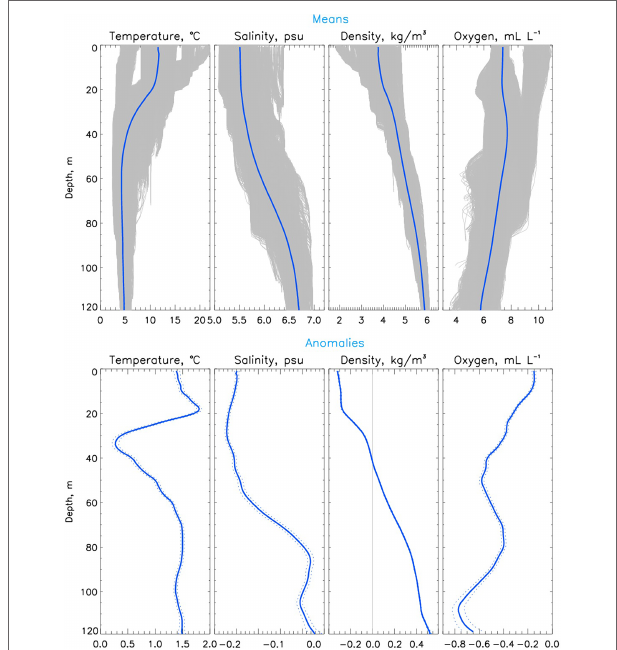
FIGURE 8 | (Top) mean and (bottom) anomalous vertical profiles of spatially and temporally averaged water temperature, salinity, density, and dissolved oxygen based on 2016-2021 glider observations in the Bothnian Sea. In the upper row, grey lines show individual profiles whereas blue lines show their averages. Temperature, salinity and dissolved oxygen anomalies are computed relative to their monthly climatologies; dotted lines show five Standard Errors.